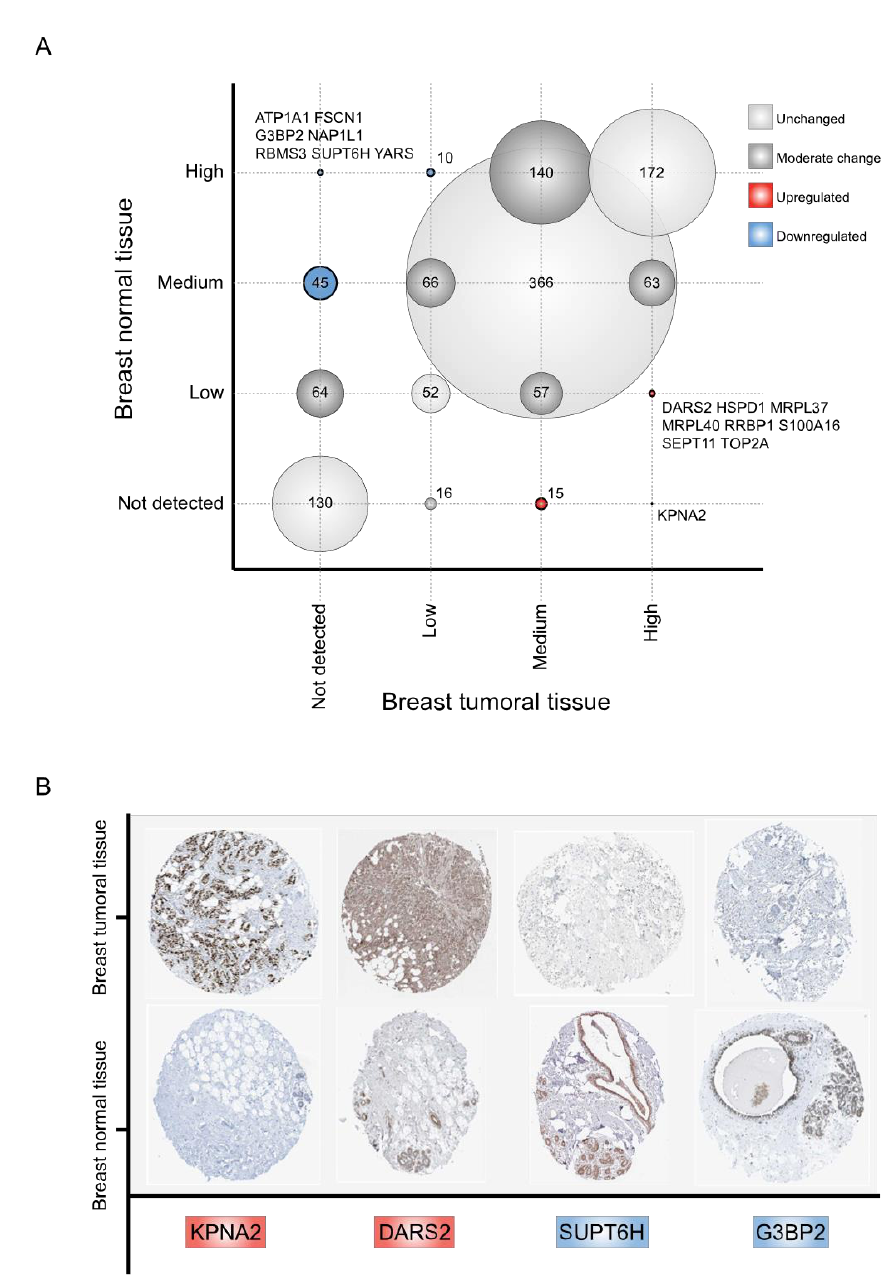
Figure 5. Immunohistochemical protein expression profile of RNA-binding proteins between healthy and tumor breast tissues. ( A ) A correlation plot, comparing RBPs immunohistochemical levels between normal and BC tissues, is presented. Circle sizes correlate with the number of RBPs in each intersection. ( B ) Representative immunohistochemical stains of four RBPS (upregulated: KPNA2 and DARS2; downregulated: G3BP2 and SUPT6H) on normal and tumor breast tissues according to the